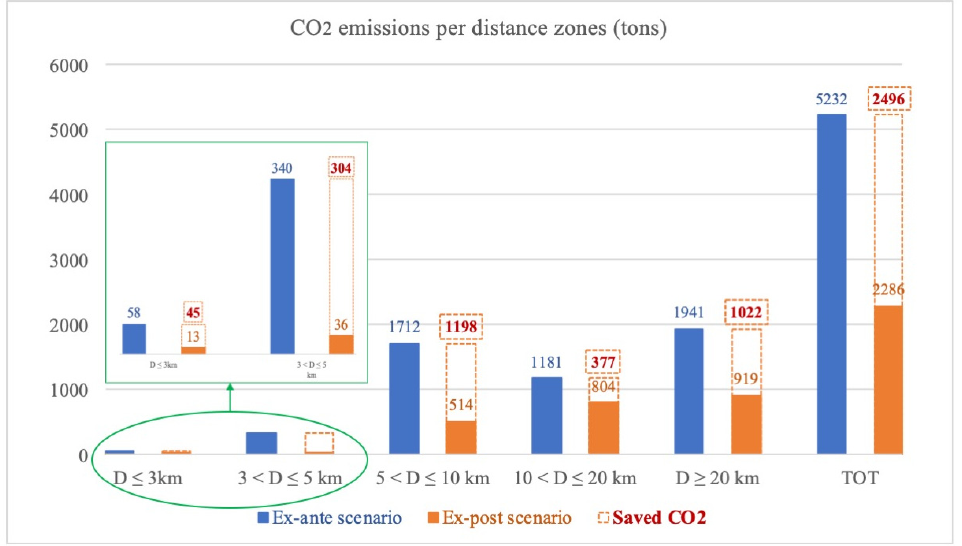
Figure 6. Yearly CO 2 (tons) releases and saved in the actual ex-ante (0) and improved ex-post (1) scenarios.